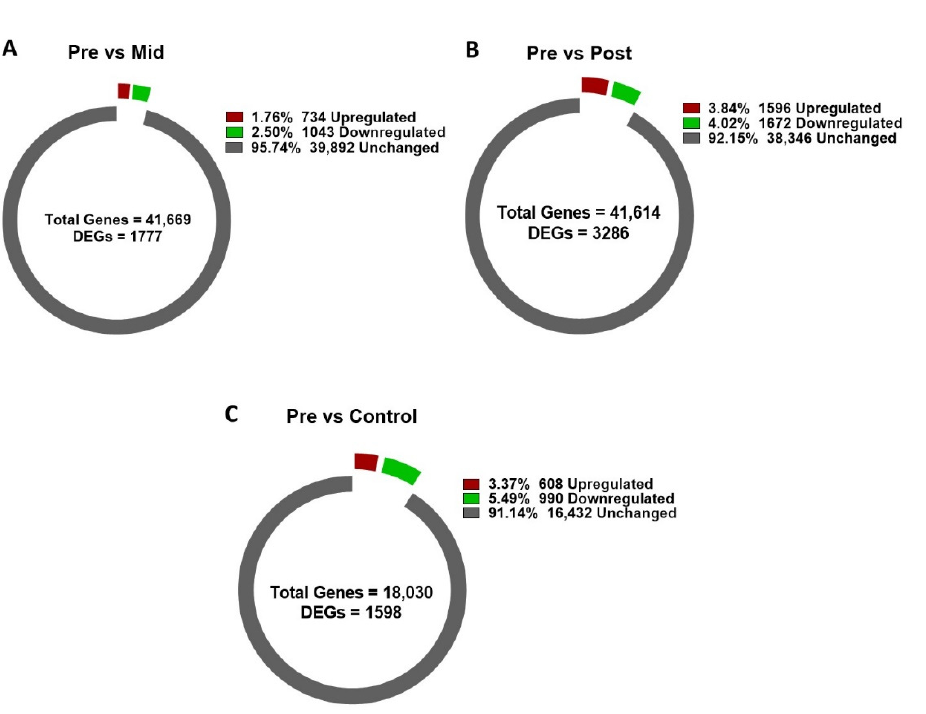
Table 3. Effect of blanching on the content of vitamins in the stem of water dropwort.